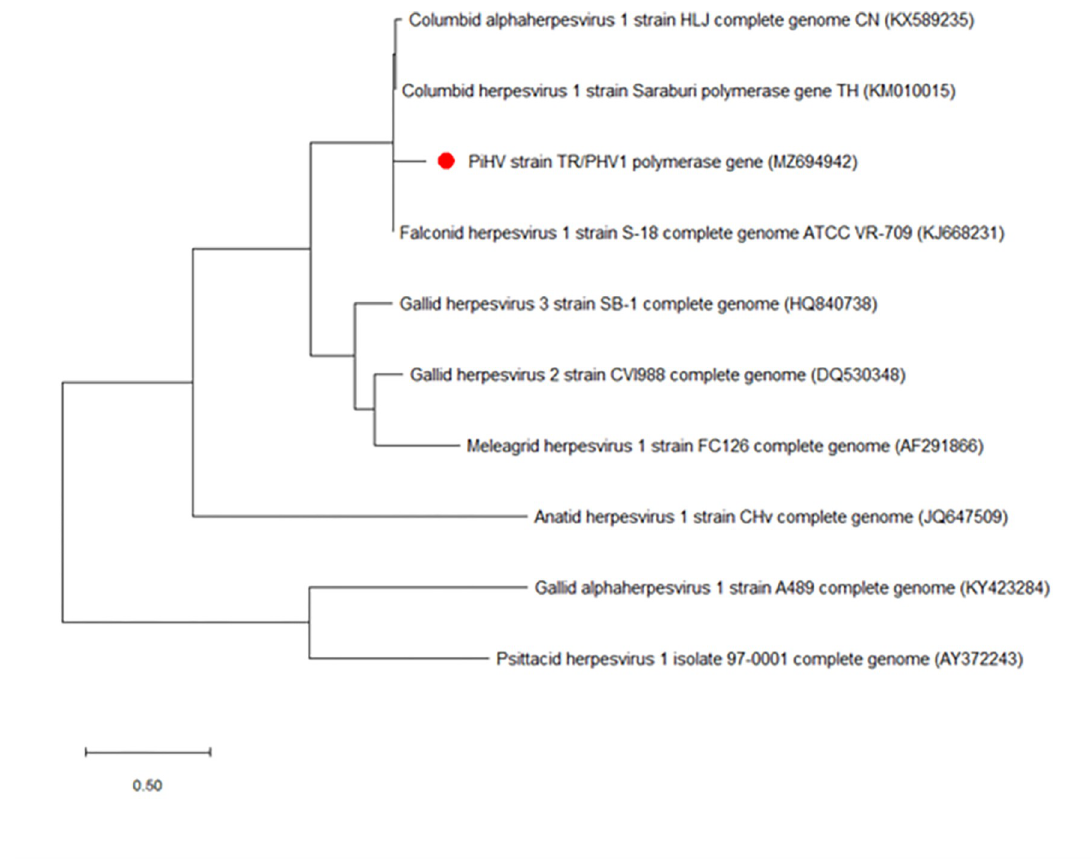
Fig 3. Phylogenetic tree based on the partial nucleotide sequence of the PiHV polymerase gene (242 bp). The tree shows herpesvirus species which affect fowl. The tree shows the names and GenBank accession numbers of each isolate. The PiHV isolate from this study is indicated by a red